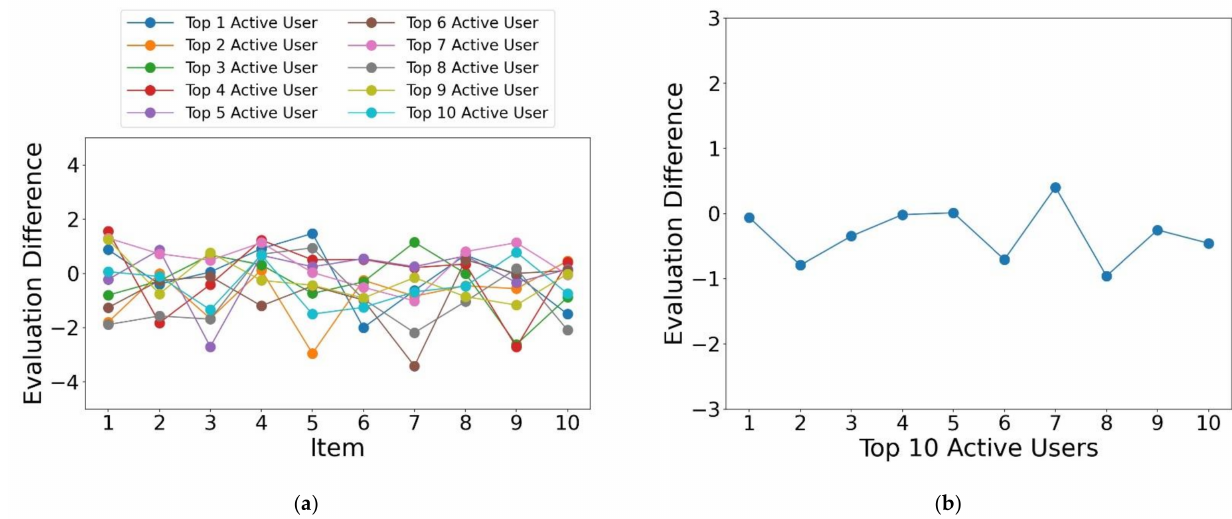
Figure 6. Evaluation difference between the top 10 active users and the average of all users: ( a ) the difference is shown for each restaurant; ( b ) the average evaluation difference is shown for each of the top 10 active